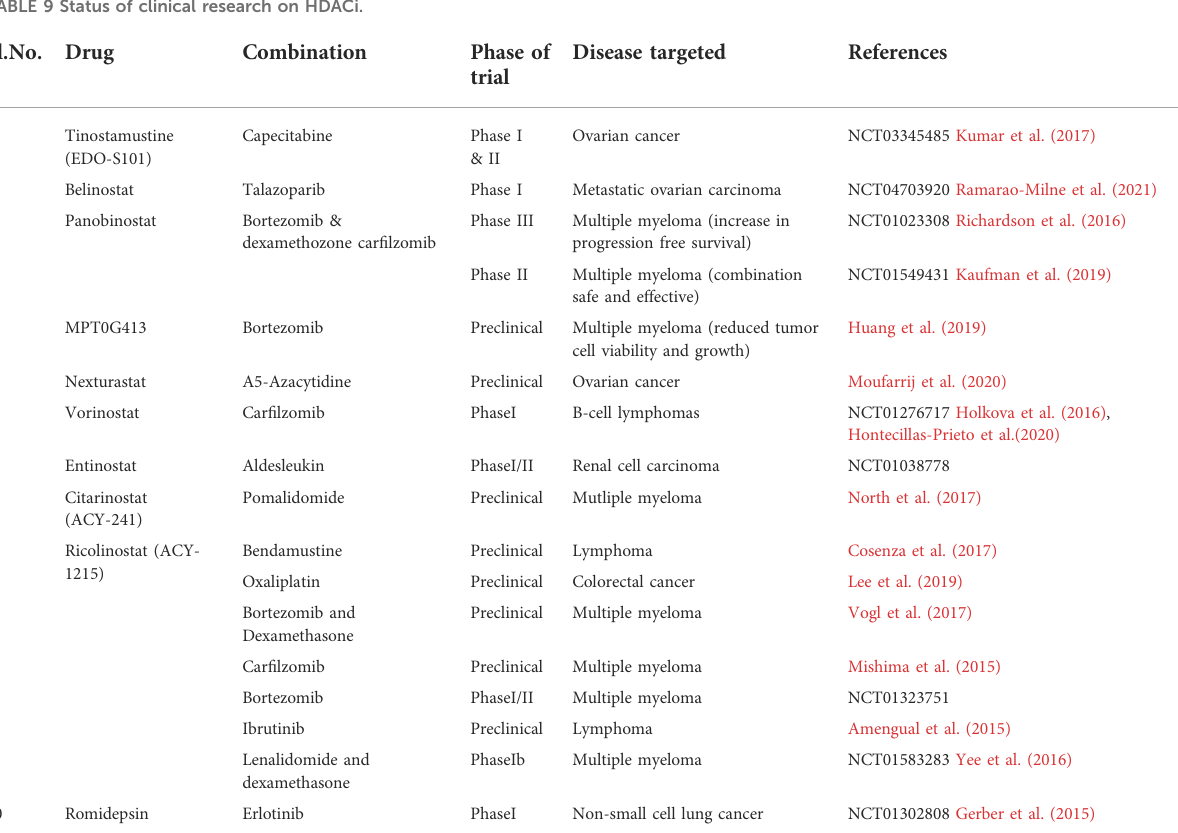
TABLE 9 Status of clinical research on